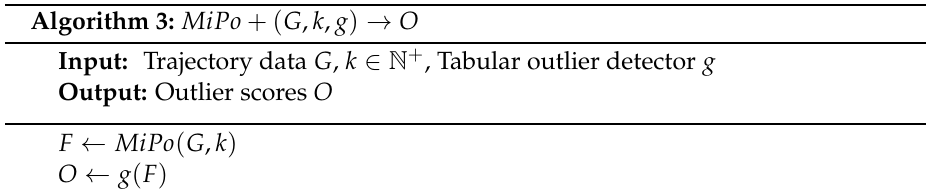
Algorithm 3: MiPo + ( G , k , g ) →